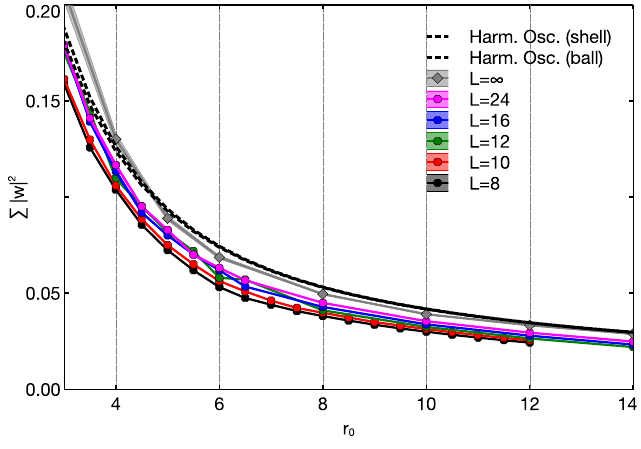
(cid:16) (cid:17) R dt j w P 9 1 2 Figure 7 . Vaules of measured on the lattice as a function of r 0 for N = 6, M j M =2 8 (cid:12) T = 2 and various L . The continuum limit is obtained by extrapolating the (cid:12)nite- L points to L = 1 at each r 0 where enough values for a robust estimate are present. Even when we can not take a reliable continuum limit, we show the (cid:12)xed- L results. The perturbative curve is obtained following the procedure in appendix B with r bunch = 1 : 91, N = 6 and T = 2. The continuum